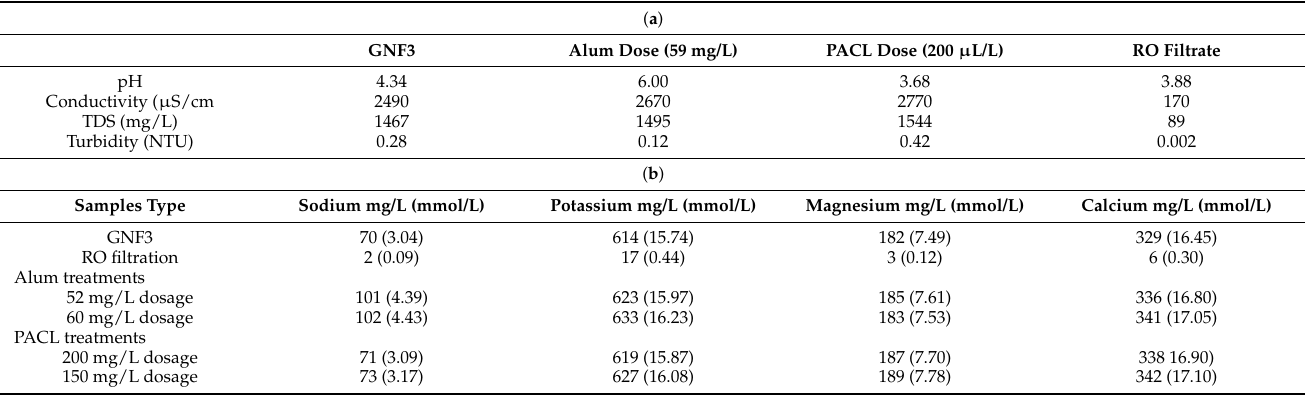
Table 5. (a) Baseline analytical results of leached and pretreated GNF3 from GH2. ( b ) Metal analysis results of GNF3.